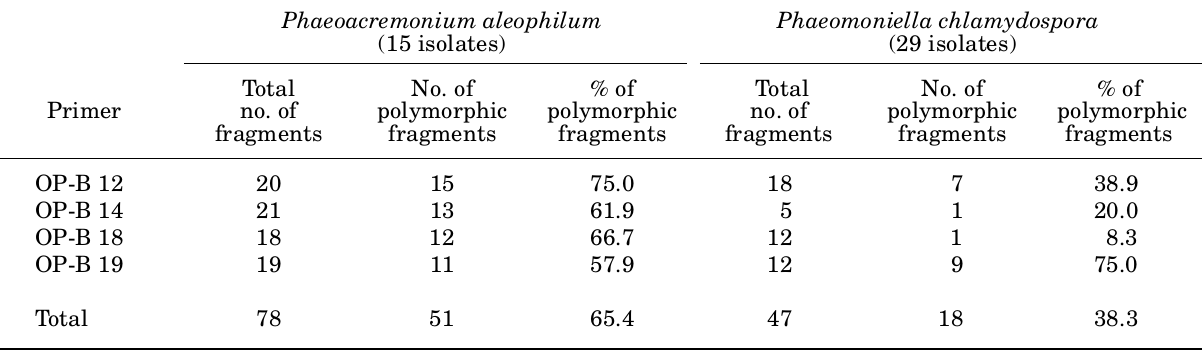
Table 1. Total number of fragments, number and percentage of polymorphic fragments, as amplified by four